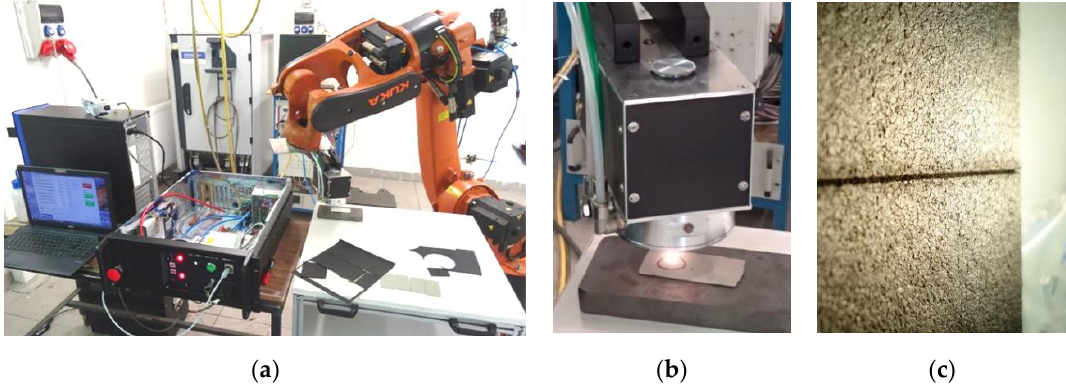
Figure 6. ( a ) Thulium all-fiber laser material processing testing workplace with robotic arm; ( b ) Detail of the laser head during cutting of synthetic leather with thickness of 1 mm; ( c ) Detail of a cut in SBR (Styrene Butadiene) rubber material.